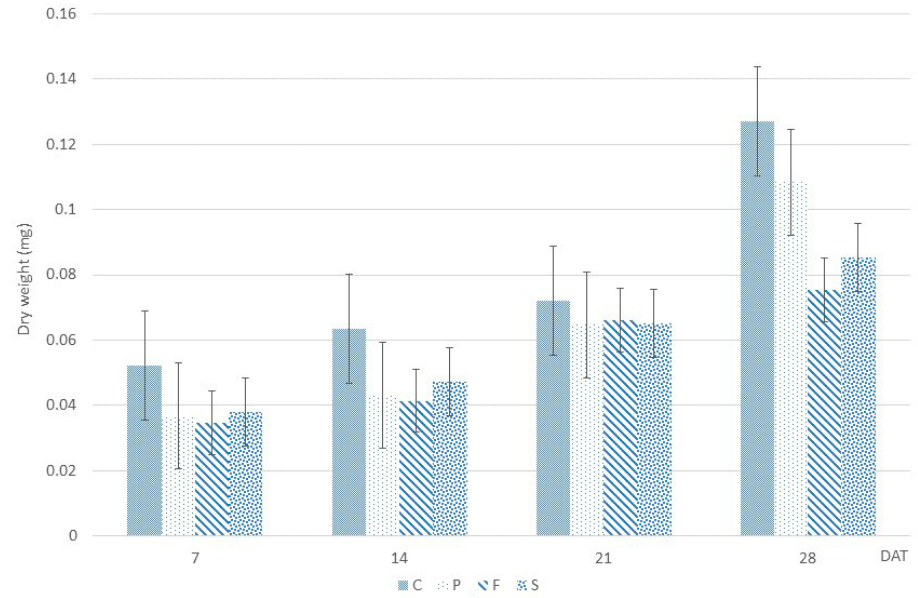
Figure 1. The biomass accumulation of Catharanthus roseus seedlings treated with different fungi- cides compared to untreated, harvested at different time points. The numbers correspond to har- vesting time (7, 14, 21, and 28 days after treatment) and the letters to fungicides (P—Pronto Plus, F—Folicur and S—Switch) and control—C. Data present the average and standard deviation of trip- licates for each time point of each condition.